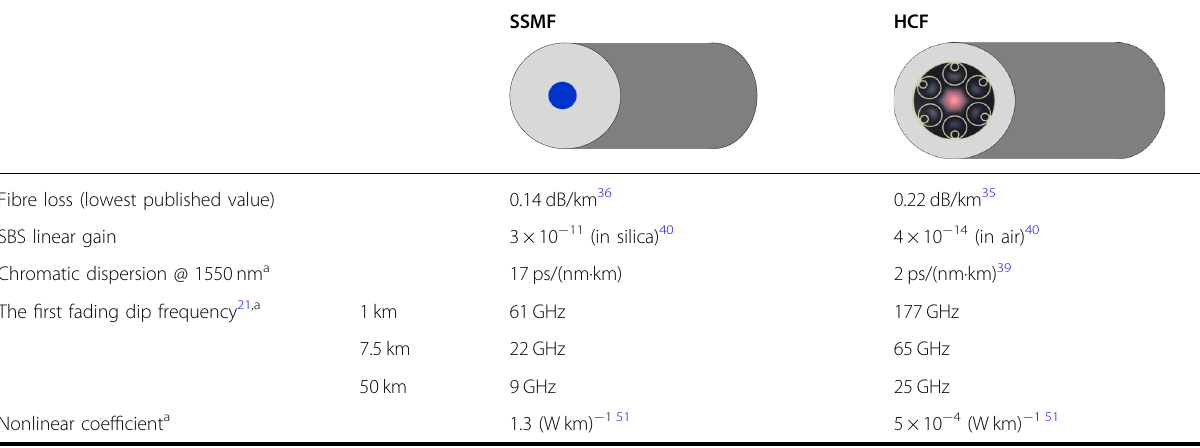
Table 1 Key properties of SSMF and HCF (NANF type) relevant for